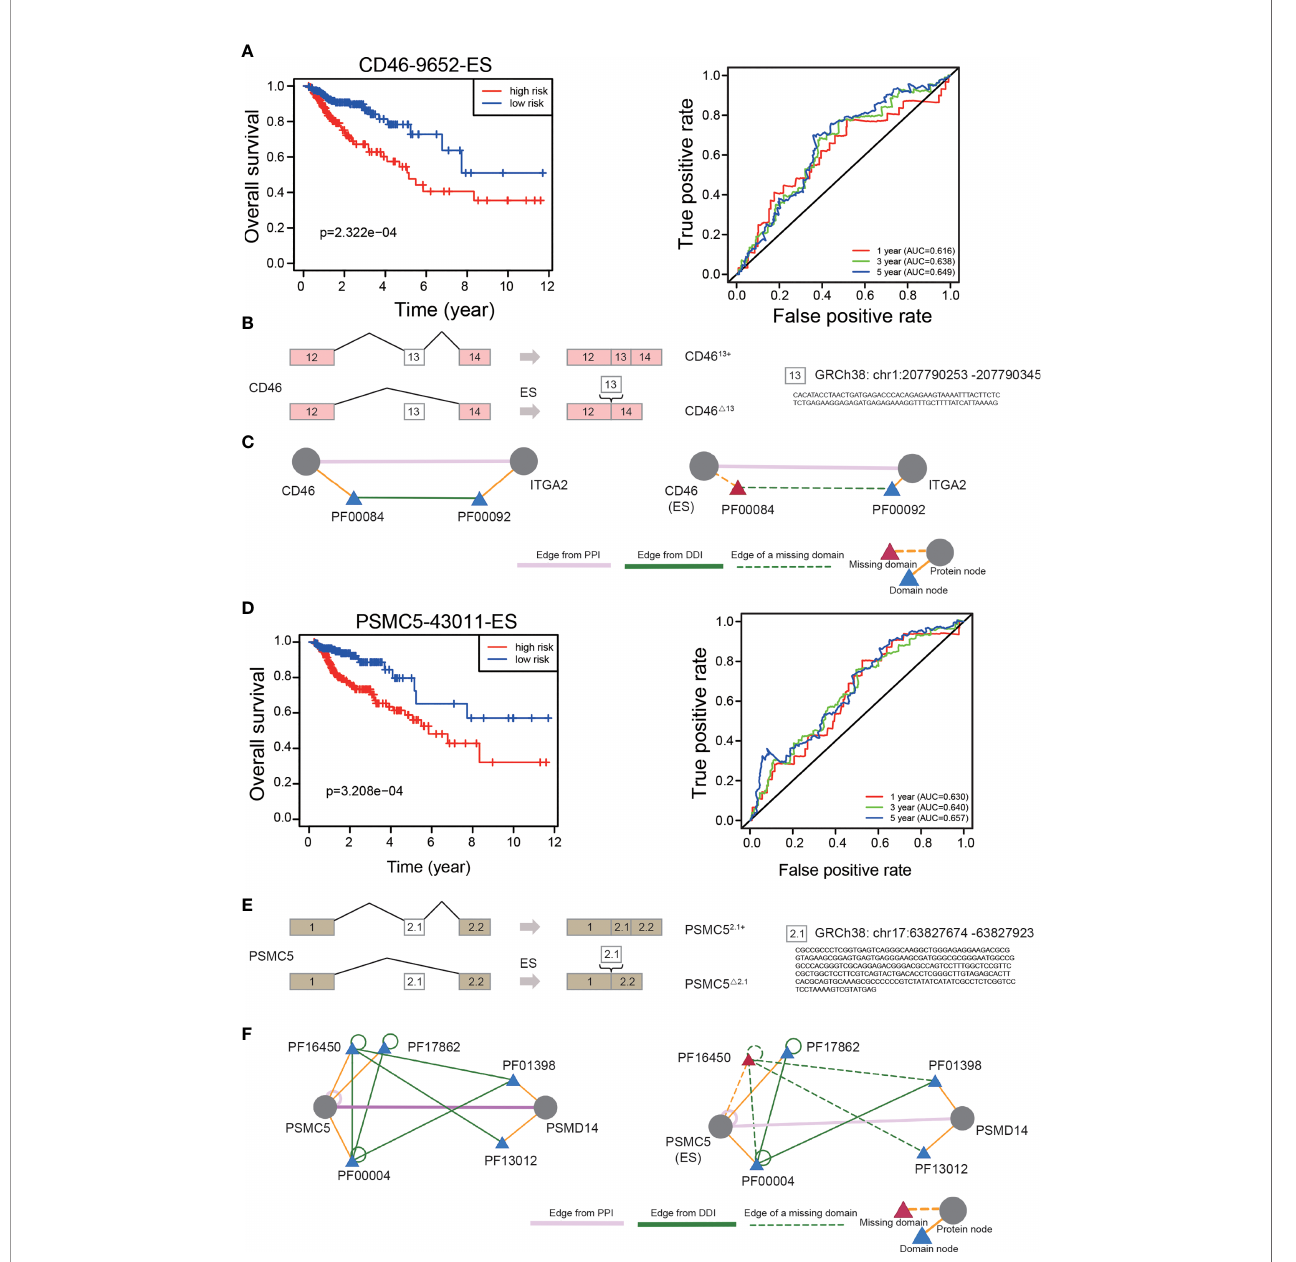
FIGURE 8 | The prognostic value of independent OS-ASEs with downstream effects. (A) The Kaplan – Meier and 1-, 3-, and 5-year ROC curves of the OS prognostic model based on CD46-9652-ES. (B) The AS changes of CD46. (C) The change of interaction between CD46 and ITGA2 after different AS events of CD46. Triangles represent protein domains. The ES of CD46 can result in losing PF00084, which is the only domain that interacts with PF00092 of the ITGA2 protein. (D) The 1-, 3-, and 5-year ROC curves and Kaplan – Meier curves of the OS prognostic model based on PSMC5-43011-ES. (E) The AS changes of PSMC5. (F) Three domains of PSMC5 that mediate the interaction with PSMD14 and two of the three interactions are lost due to PSMC5 exon